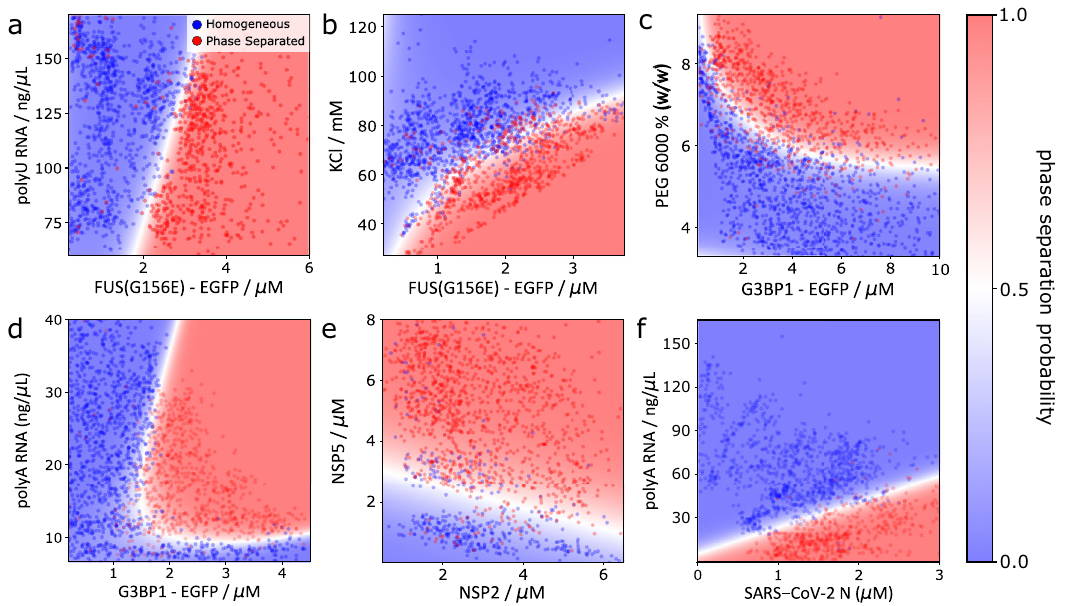
Fig. 2 | Application of PhaseScan to a variety of condensate systems. a Phase diagram of EGFP-tagged FUS G156E vs. polyU RNA concentration. N =2096 droplets. b Phase diagram of FUS G156E condensation as a function of protein and salt con- centration. N =2625droplets. c PhasediagramofEGFP-taggedG3BP1vs.PEG6000 concentration. N =2549 droplets. d Phase diagram for polyA RNA-mediated phase separation G3BP1. N =3077 droplets. e Phase diagram for coacervation- condensation of rotavirus proteins NSP2 and NSP5. N =1672 droplets. f Phase